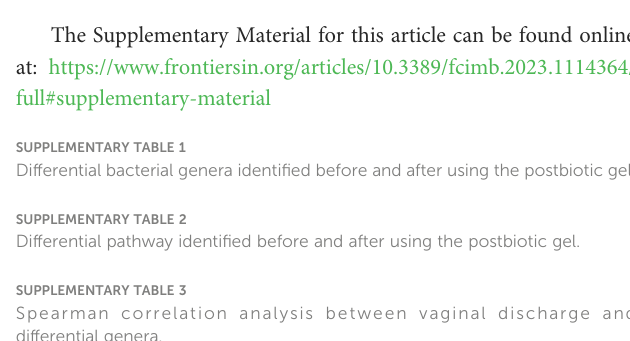
SUPPLEMENTARY TABLE 3 Spearman correlation analysis between vaginal discharge